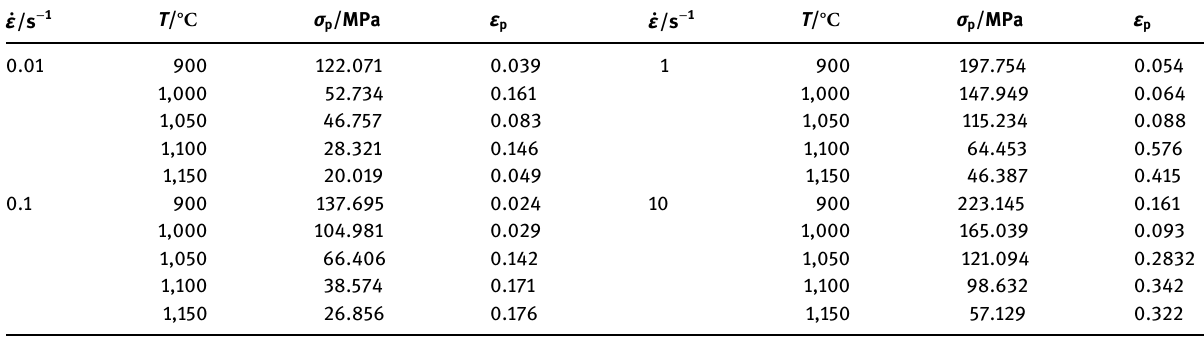
Table 2: Peak stress ( σ p ) and peak strain ( ε p ) of the samples with a series of hot compressive deformation parameters ε ̇ /s −